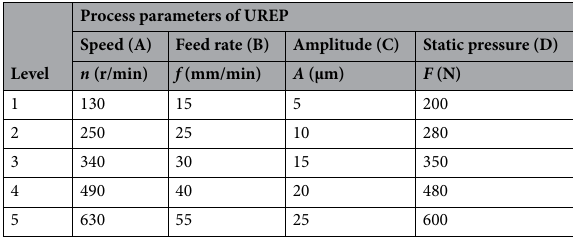
Table 5. Factor level setting